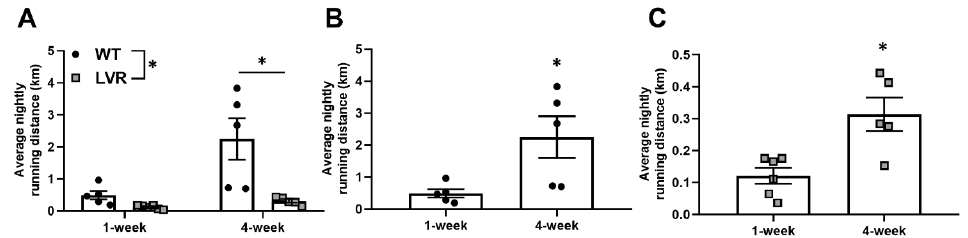
Figure 1B) and LVR rats ran ~3-fold further (0.12 ± 0.03 km vs. 0.35 ± 0.04 km; p < 0.05; Figure 1C).